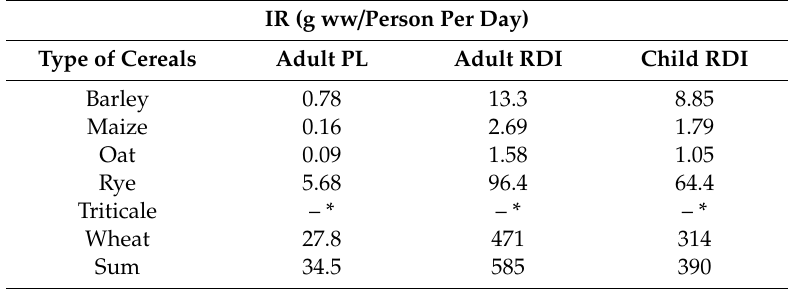
Table 2. Intake rates (IR), in g of wet weight (ww) / person per day, of the consumed species of